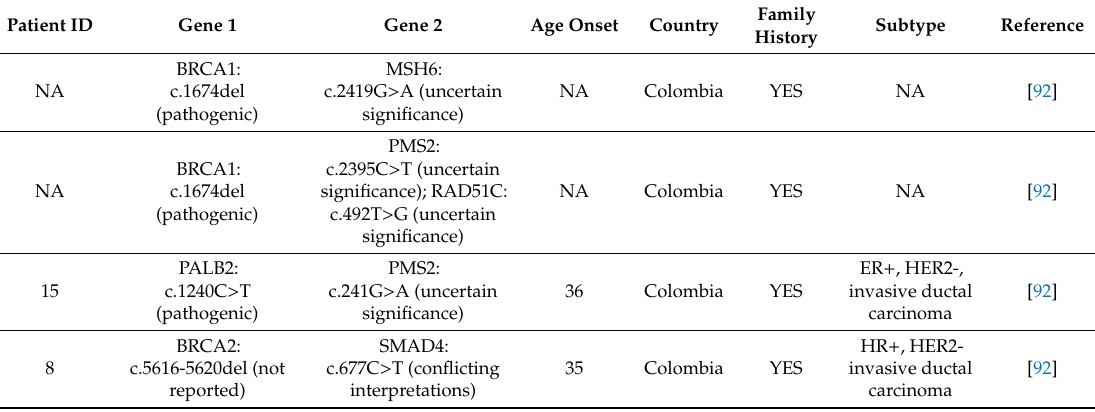
Table 6. Biallelic and locus heterogeneity mutations reported in LA breast cancer